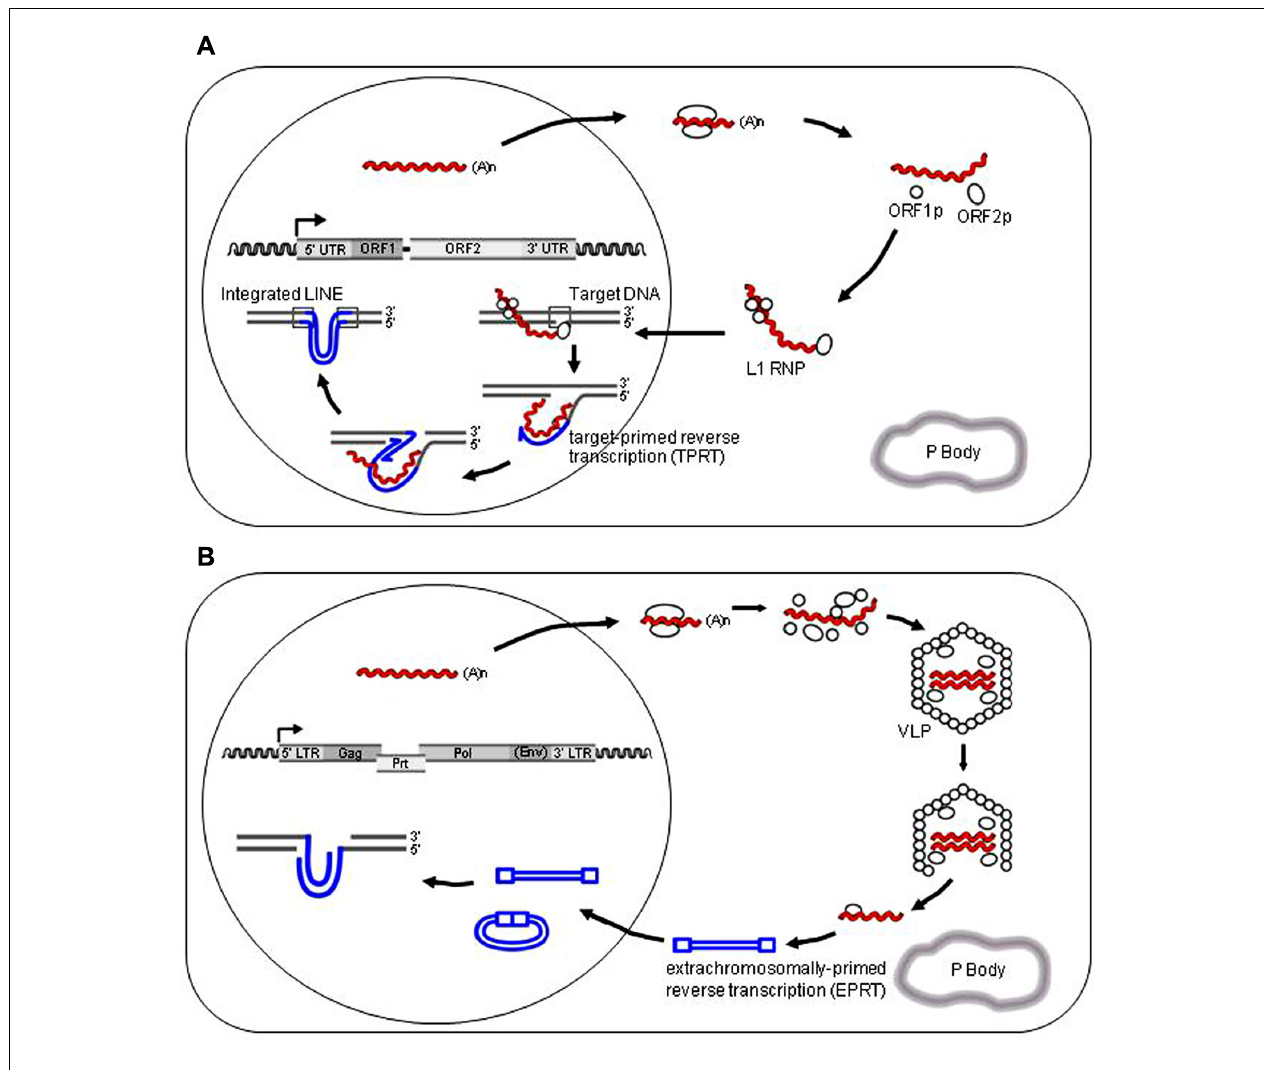
FIGURE 2 | Models for the retrotransposition cycle of retroelements. (A) The retrotransposition pathway of L1 retroelements. A functional full-length L1 element contains an internal promoter in the 5 (cid:3) untranslated region (5 (cid:3) UTR) that initiates transcription.This is followed by two long open reading frames, ORF1 and ORF2, required for retrotransposition in cis . A short 3 (cid:3) UTR is followed immediately by a poly(A) tail, and the entire element is typically flanked by target site duplications. ORF1p and ORF2p preferentially associate with their own encoding RNAs (“cis preference”) to form a RNP complex in the cytoplasm as a retrotransposition intermediate, and are critical for retrotransposition by a “copy and paste” mechanism. L1 DNA synthesis in the nucleus is based on “target-primed reverse transcription (TPRT)” in which ORF2p nicks the target chromosomal DNA, and then uses the resultant 3 (cid:3) -OH to prime the reverse transcription of L1 RNA as a template. Human APOBEC3 proteins have been documented to associate with stress granules, Staufen granules, or P-bodies (gray enclosure); however, it appears that the inhibitory activity of human